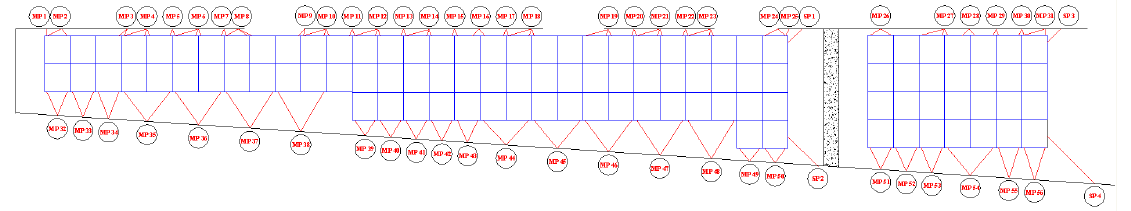
Figure 11. Mooring system of 1 MW class floating PV generation system.